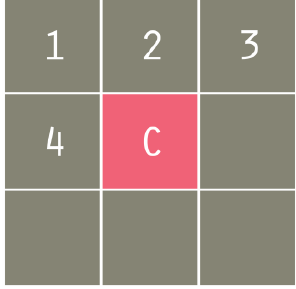
Fig. 8. 8-Neighborhood connectivity search path.